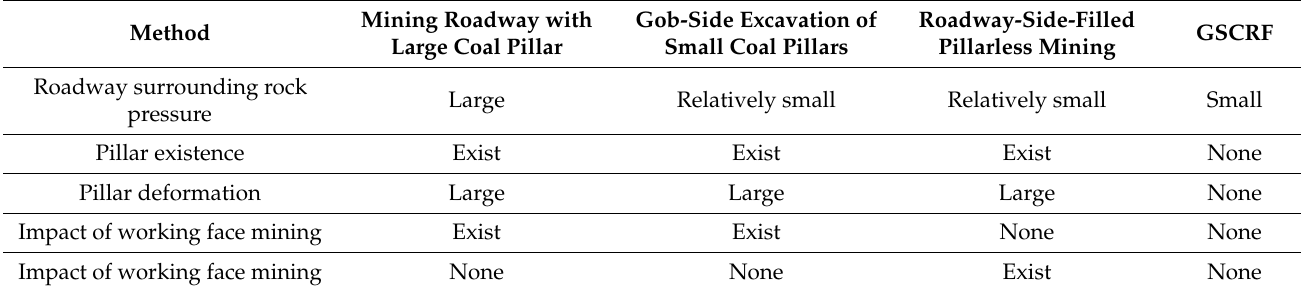
Table 4. Technical Features Comparison